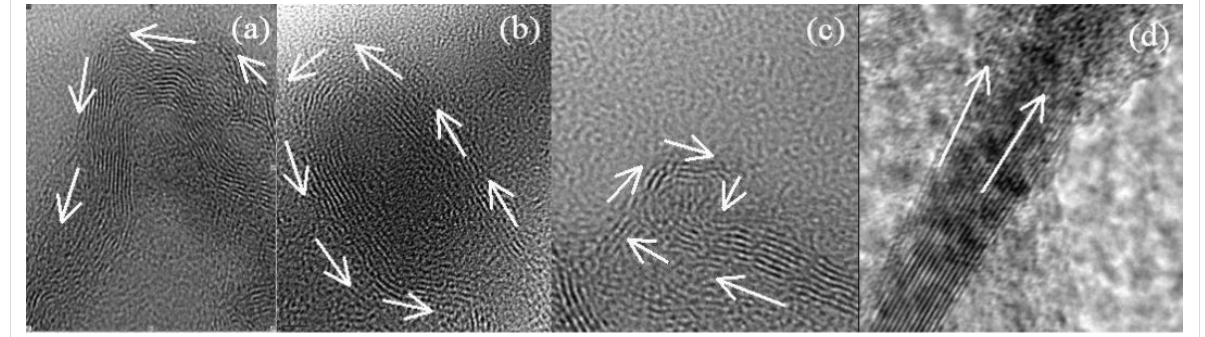
Figure 2: TEM images of BNNSs with a), curved, b), ellipse-shaped bent, c) unusual curled structures, and (d) combination of structures of ripples where tiny ripple construction are related the stacked atomic layers. Width of each ripple/atomic layers is 0.33 nm.